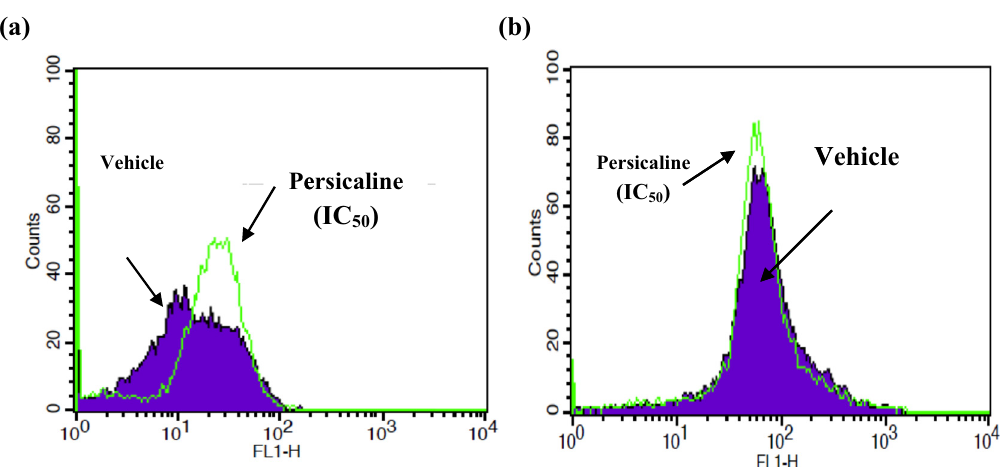
Figure 6: Persicaline - mediated intracellular ROS and MMP in MCF - 7. ( a ) ROS generation in MCF - 7 cell control ( dimethyl sulfoxide ) and after persicaline treatment acquired from fl ow cytometry experiments. ( b ) Histogram overlay showing a mitochondrial membrane depolarization of treated and untreated MCF - 7